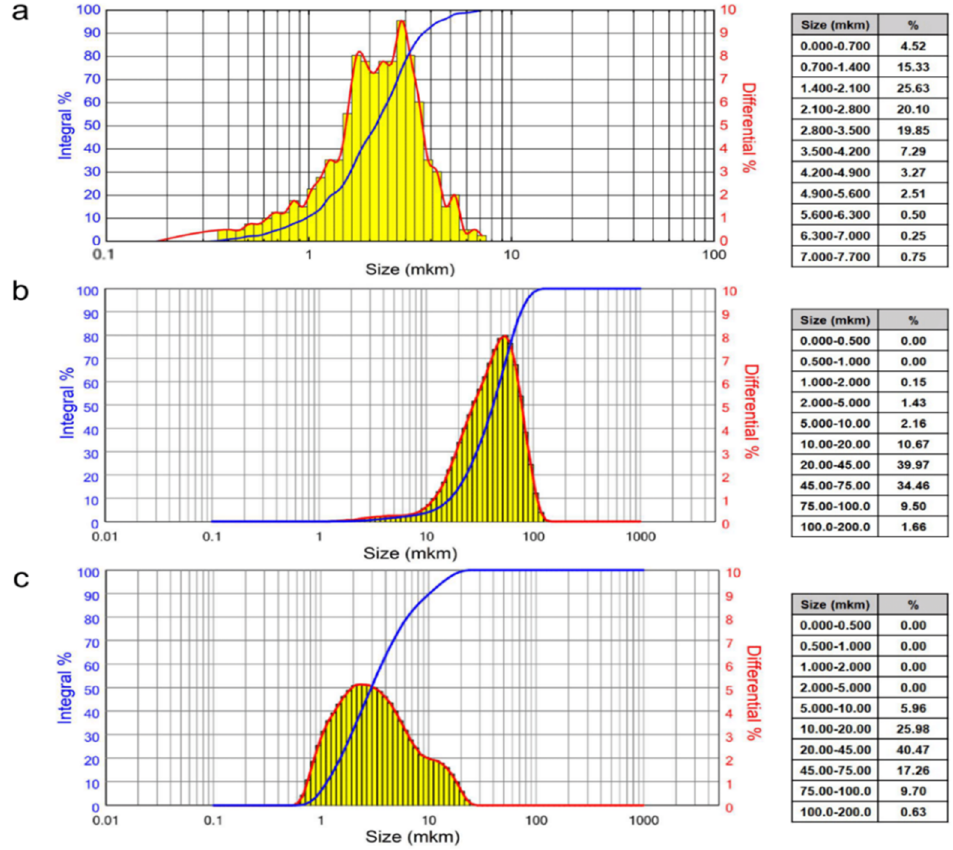
Figure 4. Particle size distribution histograms for antimicrobial additives: CuSO 4 powder ( a ); CuO powder ( b ); CuO microspheres ( c ).